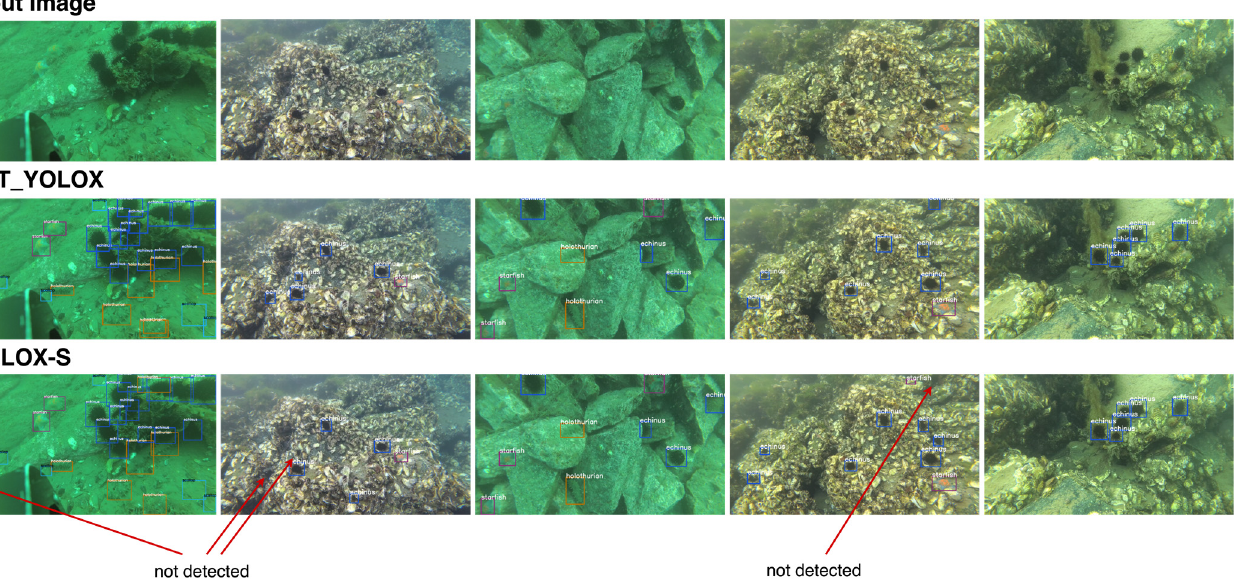
Figure 4. The qualitative comparison results of the original YOLOX-S and the proposed FFT_YOLOX model. Table 1. Performance comparisons on URPC dataset with YOLOX-S and FFT_YOLOX.